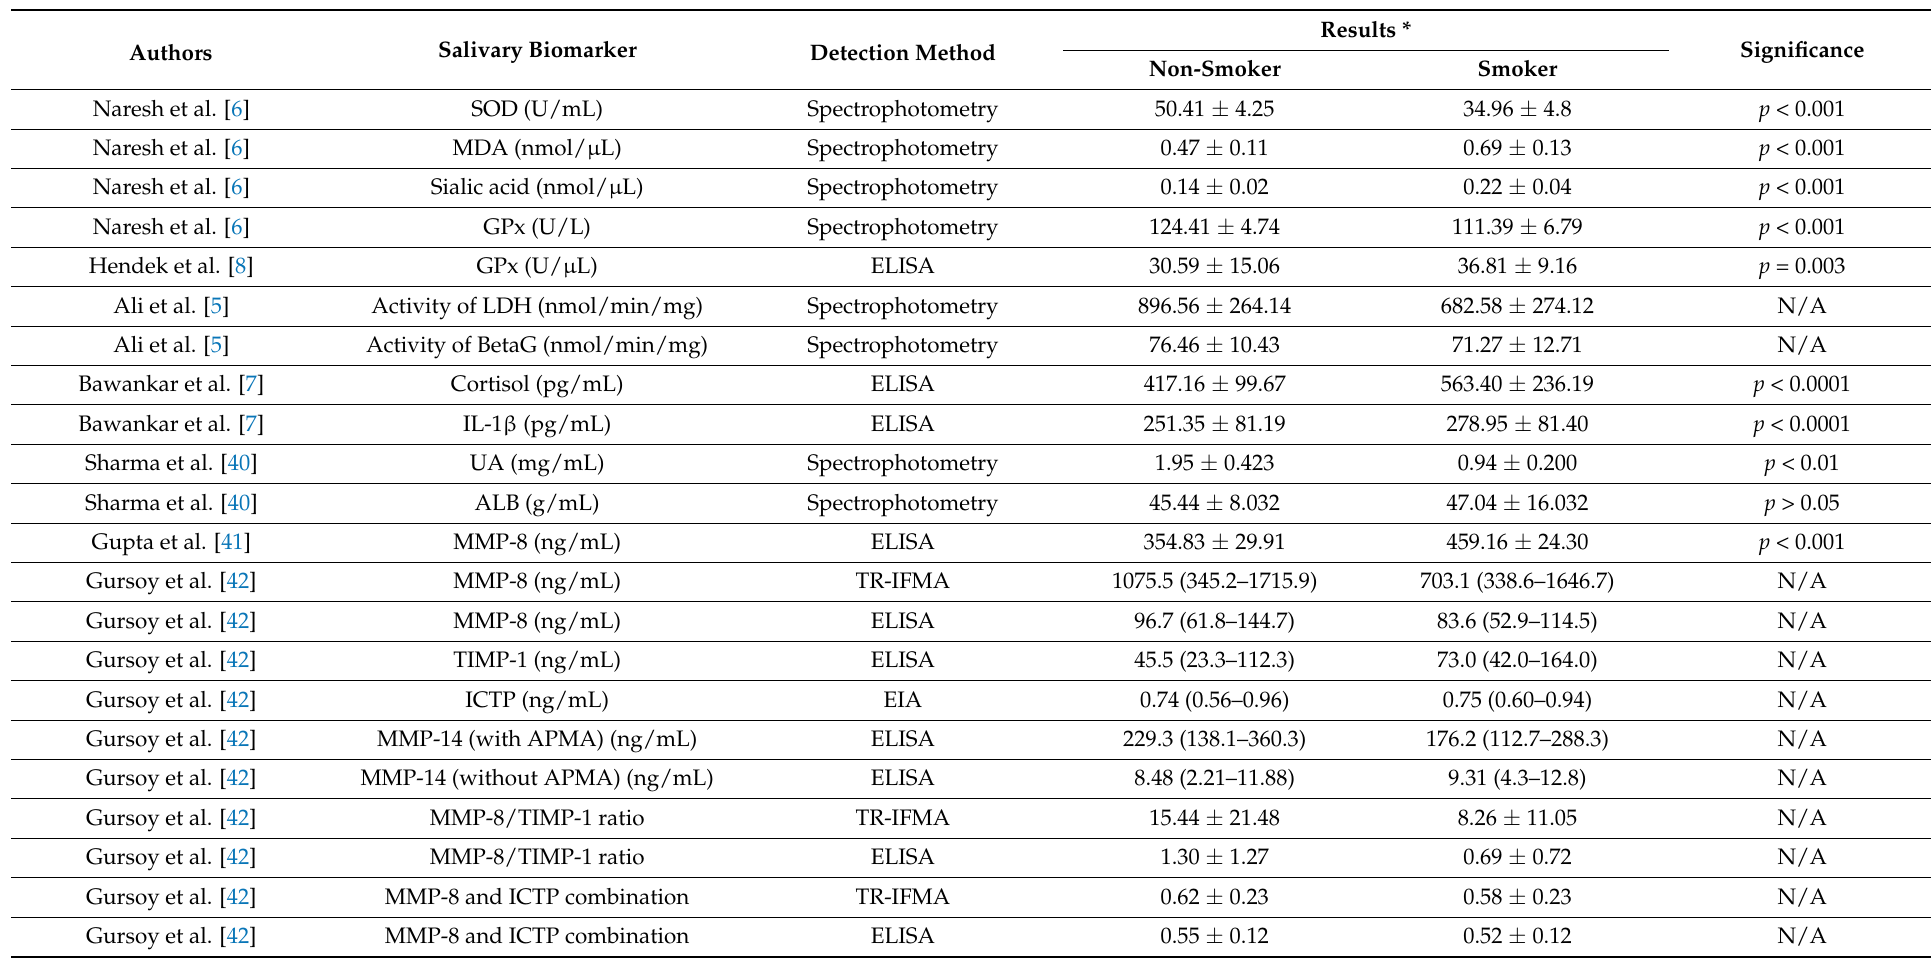
Table 4. Salivary biomarker levels based on smoking